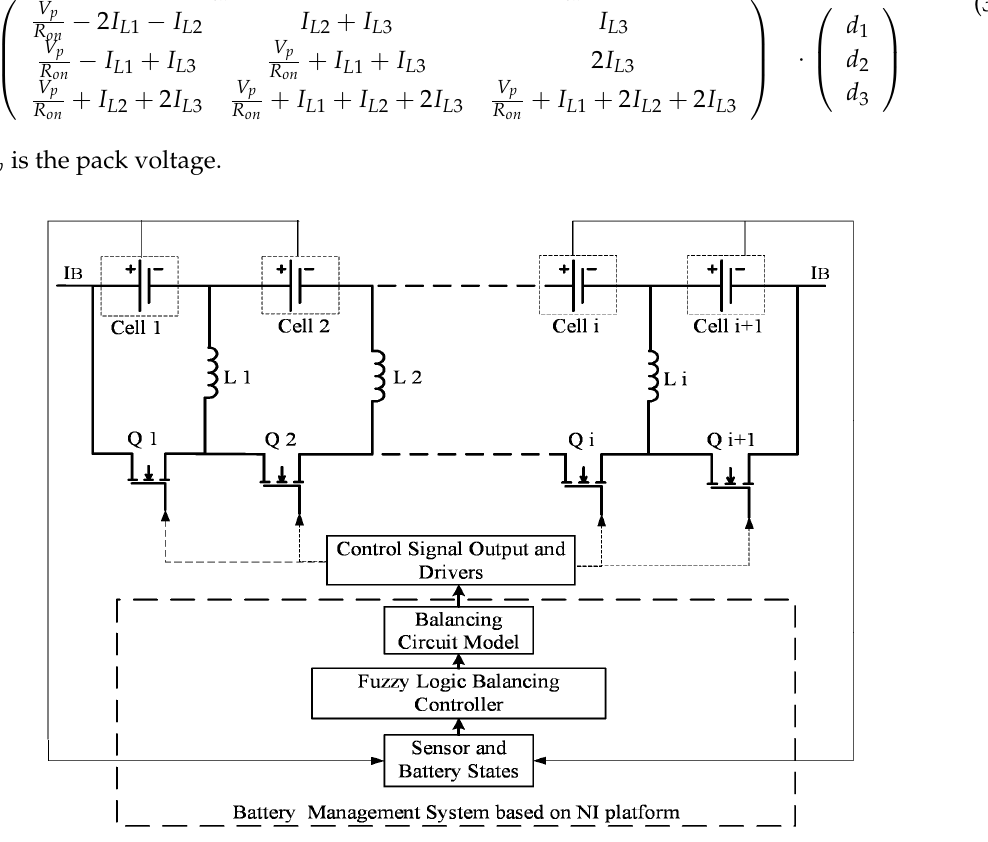
Figure 1. Multi-switched inductor balancing circuit (MSIBC)-based balancing system with a fuzzy logic (FL) controller.